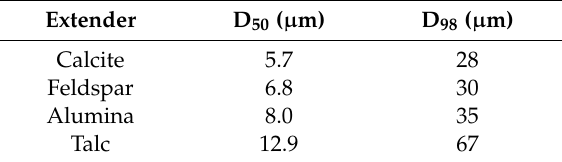
Figure 1. Particle size distribution of different extenders used with D98 mentioned in the legend. Table 1. D 50 and D 98 of the extenders used in this work.